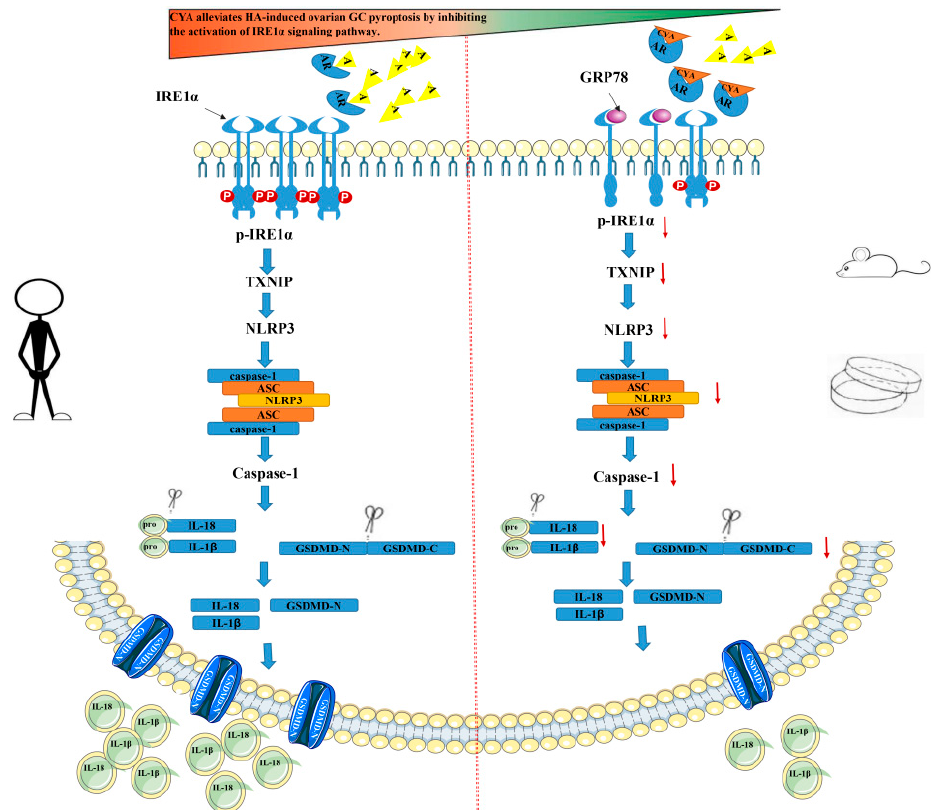
Figure 7. Schematic illustration of CYA alleviating ovarian granulosa cell focal collapse and local ovarian inflammatory response in PCOS by inhibiting IRE1 α signaling activation. A: Androgen; AR: Androgen receptor; CYA: Cyproterone acetate; GRP78: 78-kDa glucose-regulated protein; IRE1 α : Inositol-requiring enzyme type 1 α ; p-IRE1 α : Phosphorylated Inositol-requiring enzyme type 1 α ; TXNIP: Thioredoxin-interacting protein; NLRP3: The nucleotide-binding oligomerization domain- like receptor family, pyrin domain-containing 3; Caspase-1: Cysteine aspartase-1; ASC: Apoptosis- associated speck-like protein containing CARD; IL-18: Interleukin 18; IL-1 β : Interleukin 1 β ; GSDMD- C: Gasdermin-C; GSDMD-N: Gasdermin-N; “ ↓ ”indicate that expression of protein was